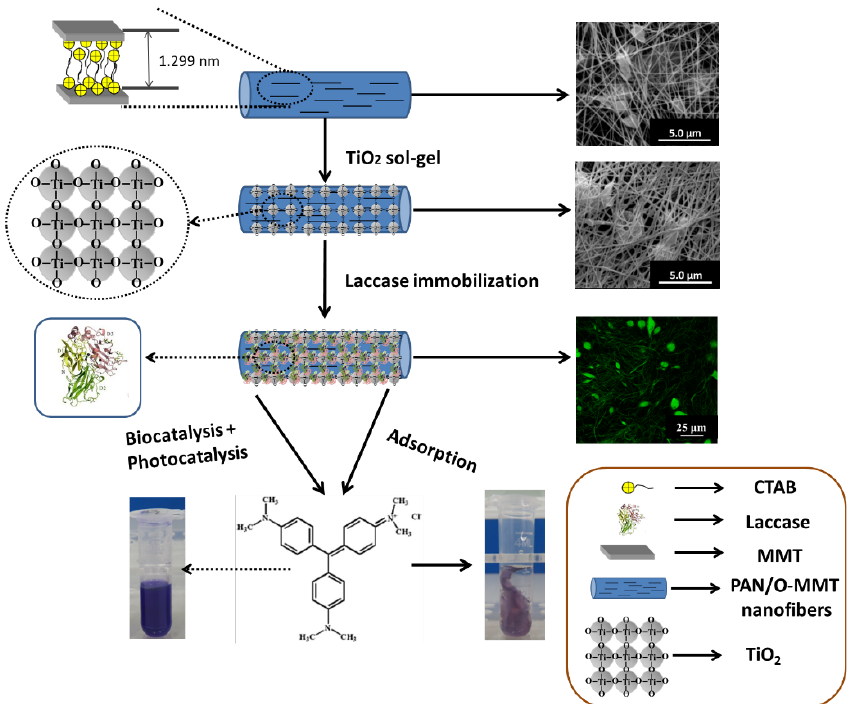
Figure 1. Schematic illustration of polyacrylonitrile/organically modified montmorillonite (PAN/O-MMT) composite nanofibers functionalized by sol-gel coating of TiO 2 and then used as support for laccase and its application in crystal violet (CV) treatment.